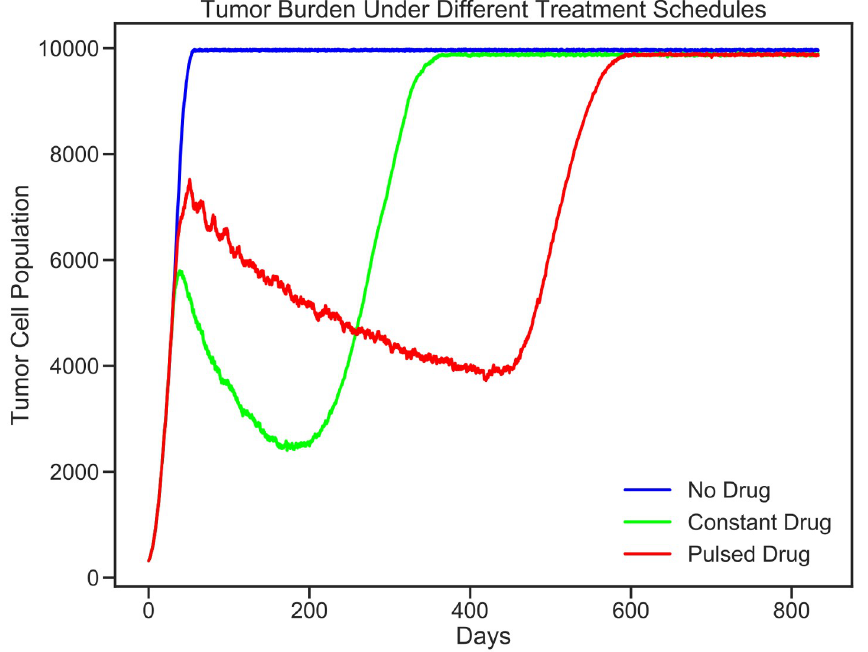
Fig 9. FileIO population output. This plot summarizes the changes in tumor burden over time for each model. This plot was constructed using data accumulated in the program output populations.csv file. Displayed using the Java XChart